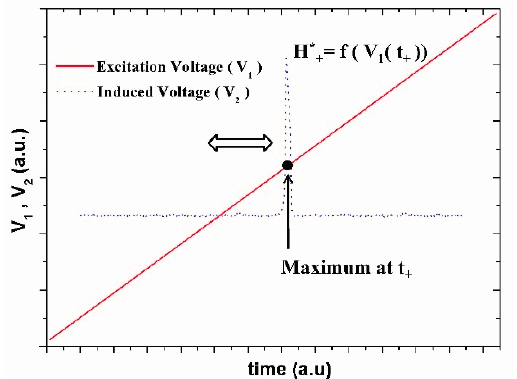
Figure 6. Sharp maximum (blue dot) appears at the end of the pick-up coil when the external field (red line) approaches the switching field.